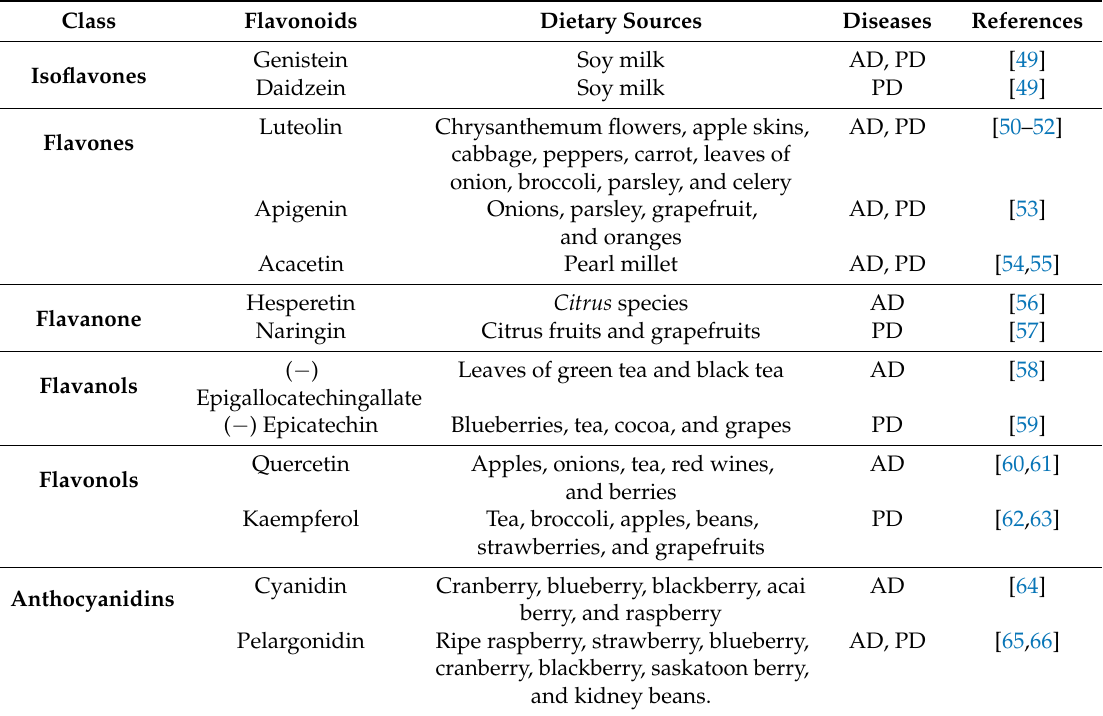
Table 1. Classification of flavonoids and their dietary